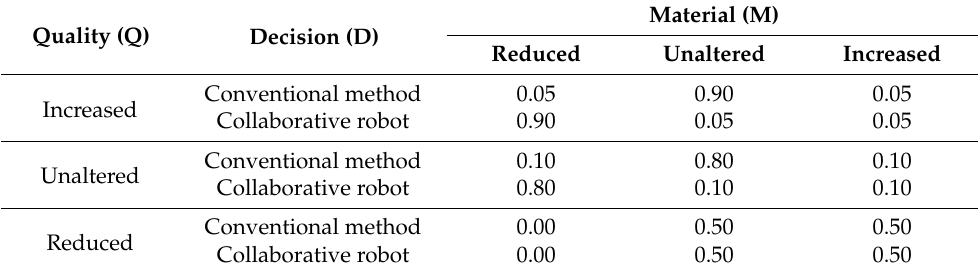
Table 4. Conditional probability table of coordination time P(M|Q,D).